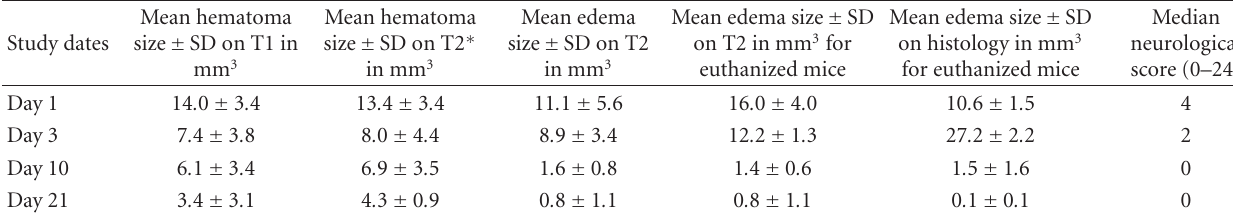
Table 1: MR volumetry and